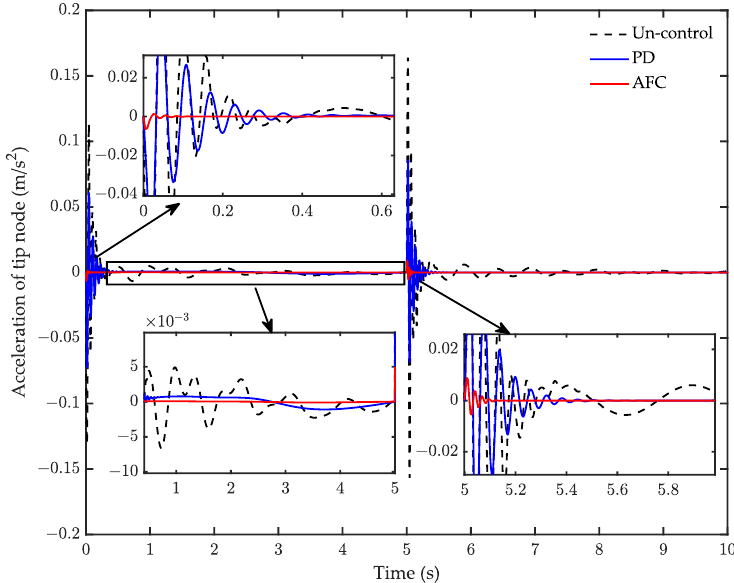
Figure 15. Simulation result of acceleration response for case 1 .